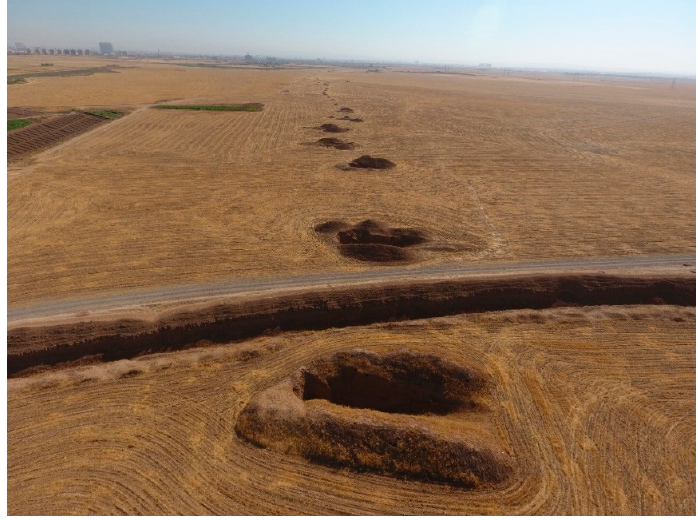
Figure 2. Alignment of shafts of an abandoned qanat ( karez ) west of Erbil, near Arab Kandi village.